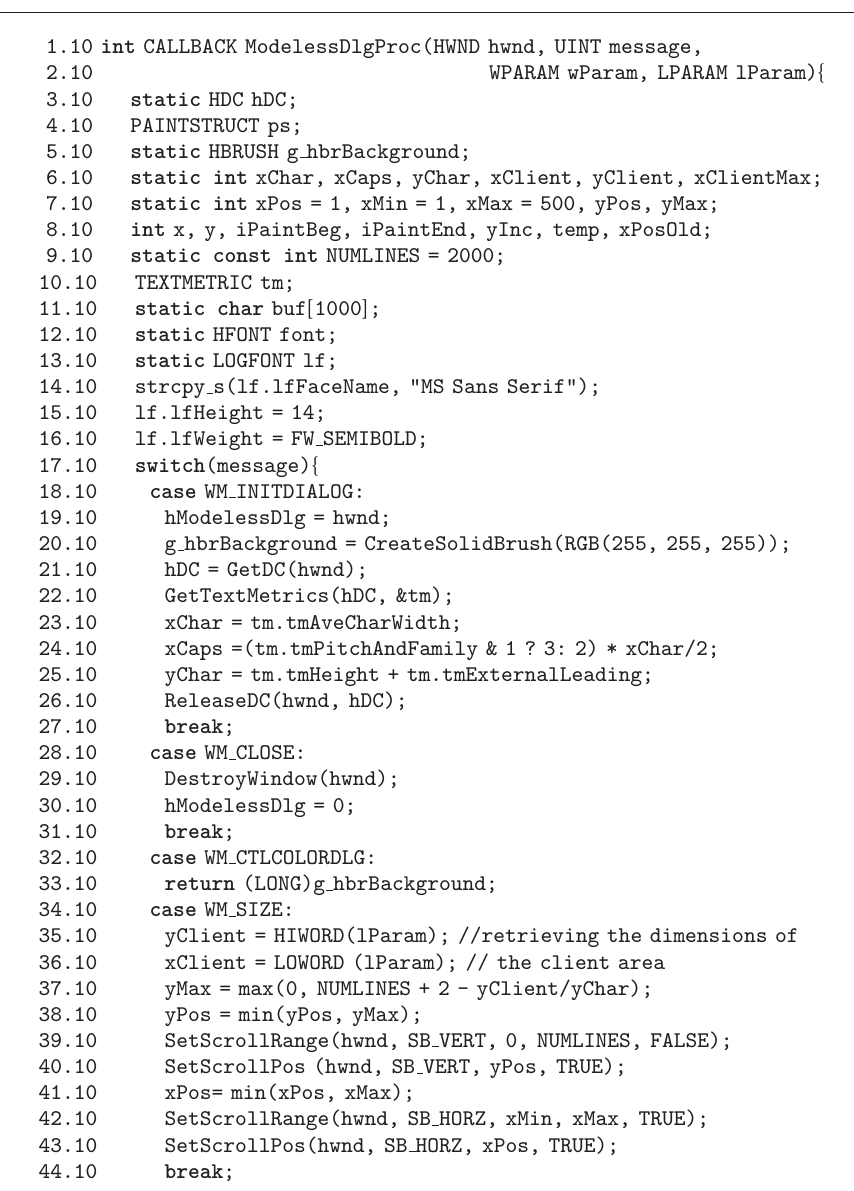
Algorithm 10: Modeless dialog box: function ModelessDialogProc (part